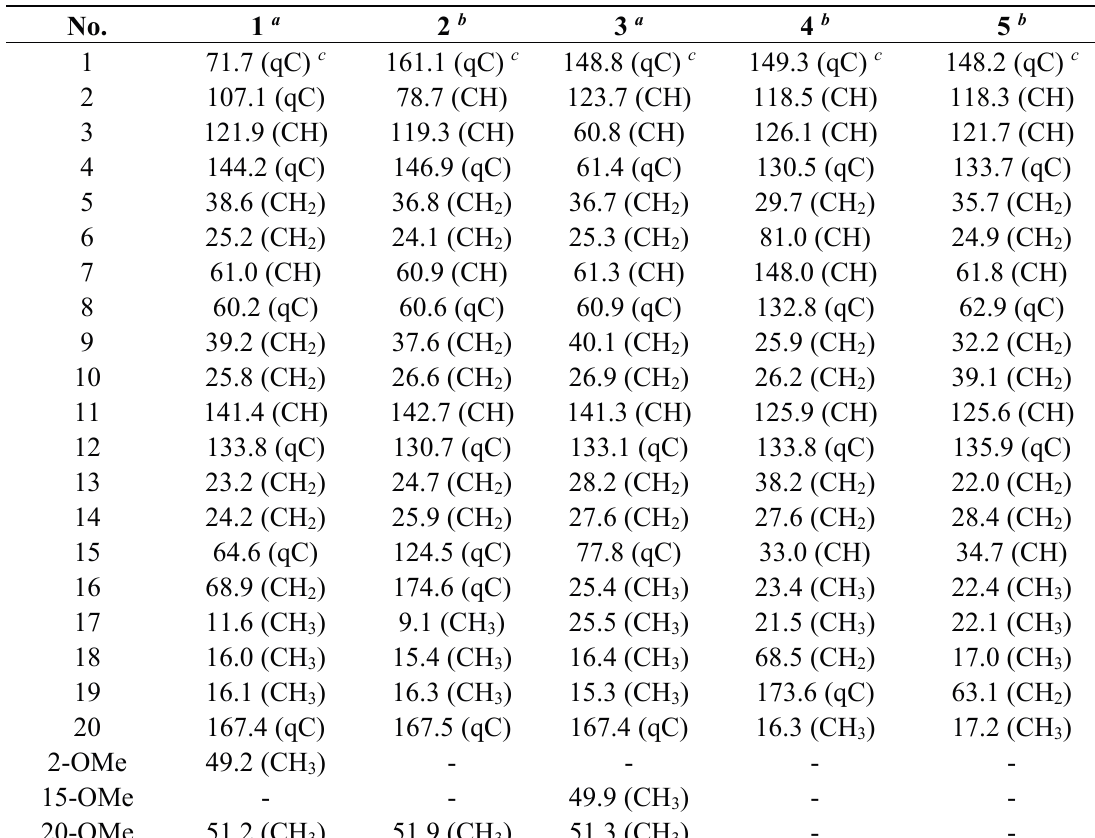
Table 2. 13 C NMR spectroscopic data of compounds 1 – 5 .